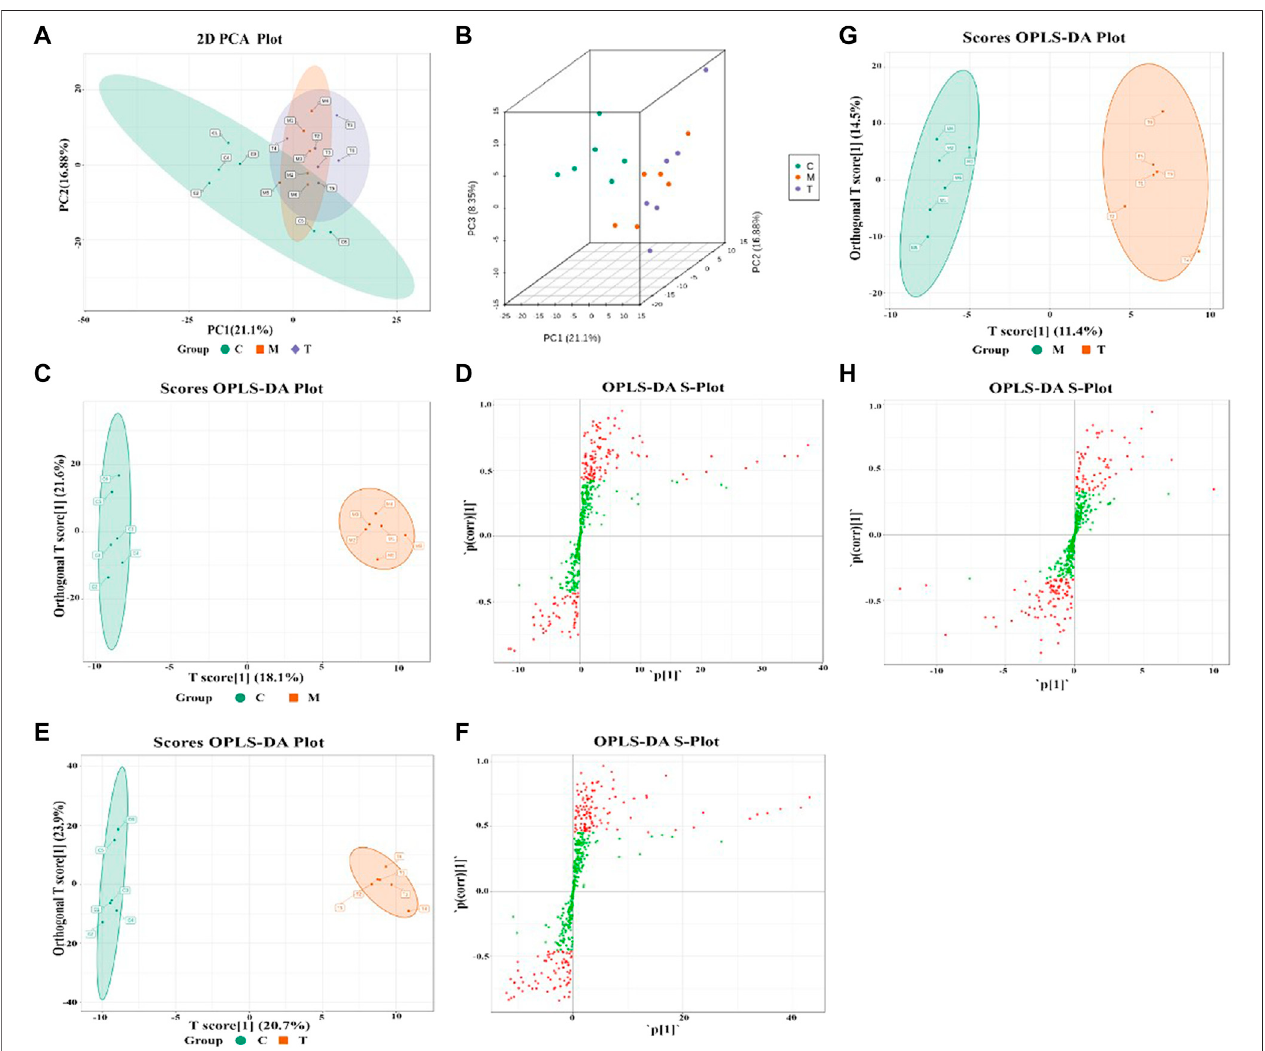
FIGURE 2 | C is the CTL group; M is the PLC group; and T is the JWXY group. (A – B) Principal component analysis (PCA) results of CTL, PLC, and JWXY groups; (C) OPLS-DA score map of the CTL group and PLC group; (D) OPLS-DA S-plot of the CTL group and PLC group; the abscissa represents the correlation coef fi cient of the main component and metabolite, and the correlation coef fi cient is represented by the ordinate. The metabolites in the upper right and lower left corners showed the mostsigni fi cantdifferences.ThereddotindicatesthemetaboliteVIPvalue > 1,whilethegreenoneindicatesthemetaboliteVIPvalue < 1; (E – F) OPLS-DAscoreplot and OPLS-DA S-plot of the CTL group and JWXY group; (G – H) OPLS-DA score and OPLS-DA S-plot of the PLC group and JWXY group.